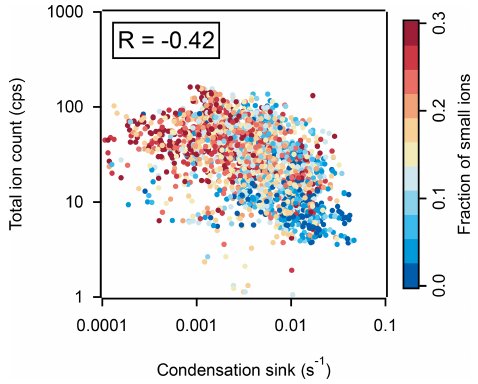
Figure 3. Correlation between the TIC measured by APi-TOF and condensation sink, colored by the fraction of small ions (defined as concentrations of ions with diameter < 2nm to the total ion con- centrations) determined from NAIS data. Data are shown at a time resolution of